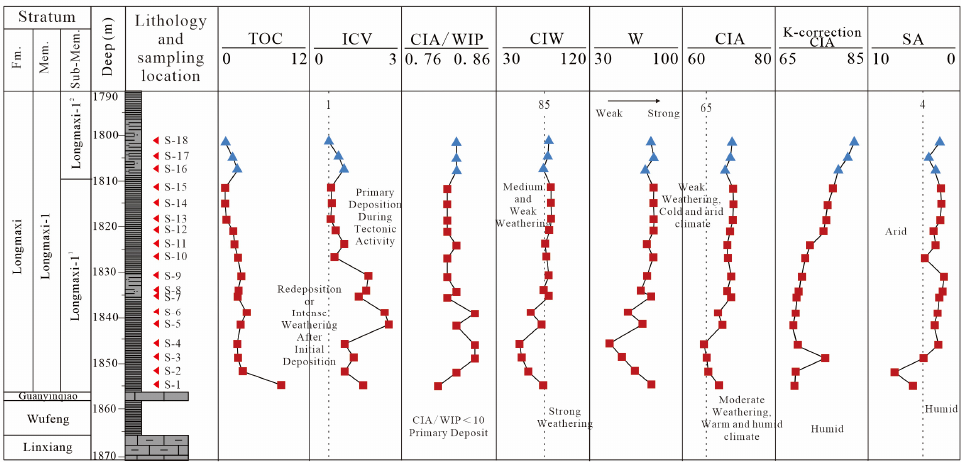
Figure 4. The vertical variation of TOC content and weathering indices in Longmaxi-1 black shales.